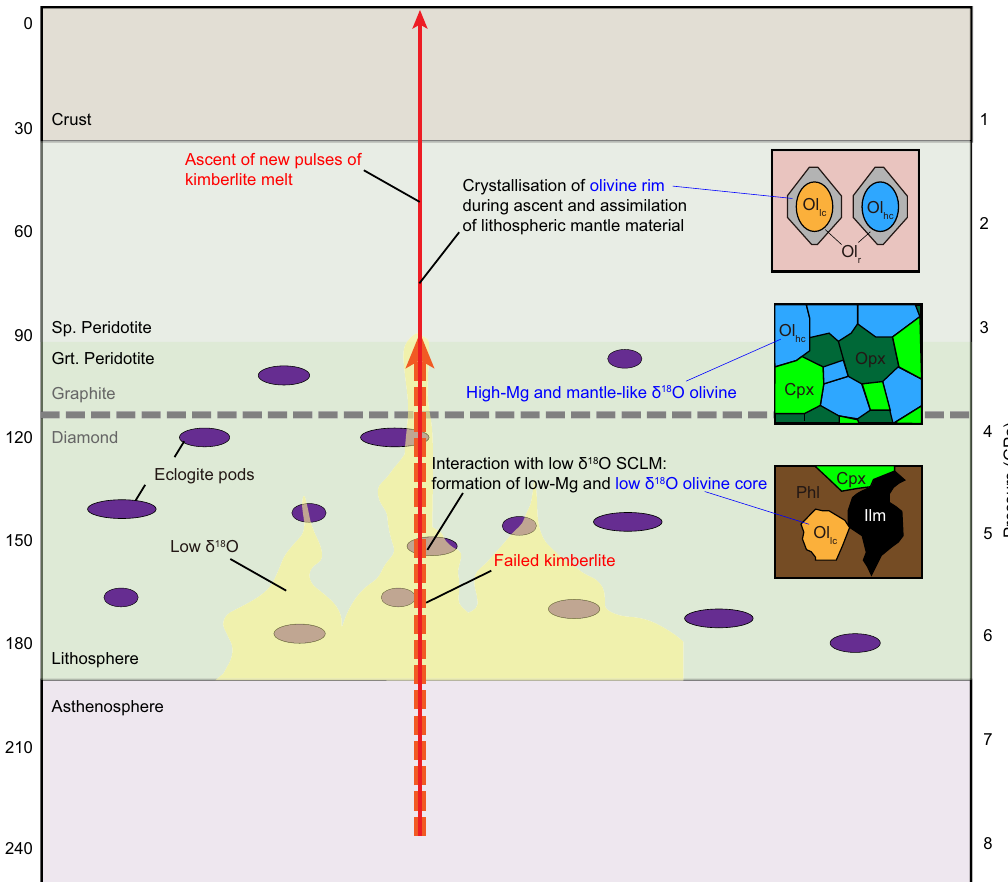
Fig. 6 Schematic illustration showing the genesis of oxygen isotope variations in the cores and rims of kimberlitic olivine. High-Mg olivine cores with mantle-like δ 18 O represent xenocrysts derived from coarse-grained granular peridotites. Failed pulses of kimberlite magma may interact with low- δ 18 O metasomatic lithologies (± eclogites) in the sub-continental lithospheric mantle (SCLM) and generate low-Mg, low- δ 18 O olivine including olivine megacrysts and olivine in polymict breccias. Later pulses of kimberlite magma entrain wall-rock xenoliths and xenocrysts, including olivine, and crystallize olivine rims over cores of variable composition (both high-Mg and low-Mg). If the lithospheric mantle column traversed by kimberlite magmas is suf fi ciently enriched in metasomatised low- δ 18 O material, which is partially assimilated, the kimberlite melts crystallize low-Mg, low- δ 18 O olivine rims. Ol lc low-Mg olivine core, Ol hc high-Mg olivine core, Cpx clinopyroxene, Opx orthopyroxene, Phl phlogopite, Ilm